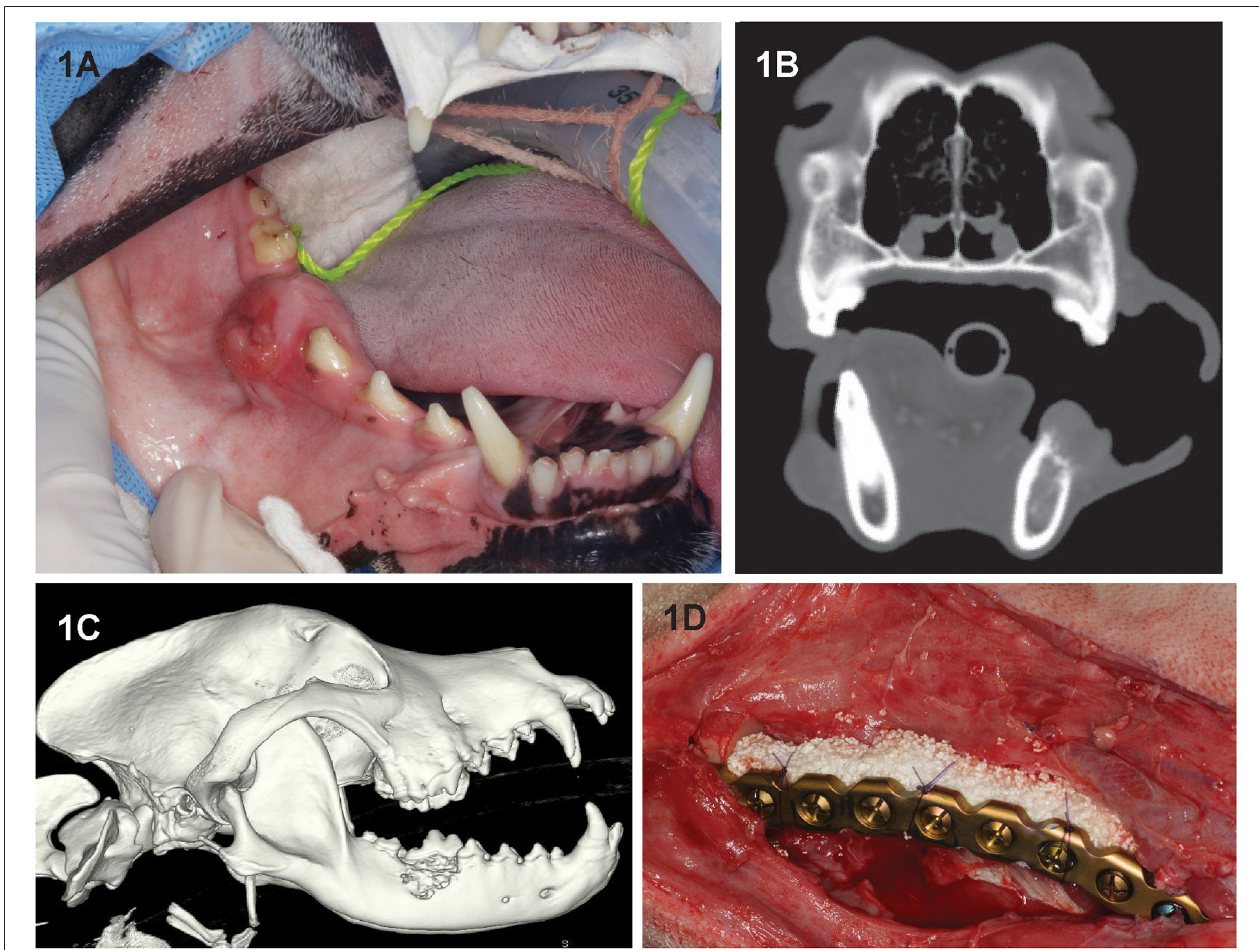
FIGURE 1 | Clinical image (A) of dog 2 prior to segmental mandibulectomy of histologically confirmed CAA at the level of right mandibular first molar tooth. (B) Sagittal-plane and (C) lateral view 3D volume rendering CT images of the same dog. Note that the neoplastic process extends almost to the ventral border of the mandibular canal and exhibits an osteodestructive pattern characteristic of CAA involving the dorsal half of the mandible. (D) Intraoperative image following mandibulectomy, replacement of the previously contoured reconstruction plate and insertion of rhBMP-2-soaked CRM implant into the defect (D) . The implant was secured to the plate using circumferentially placed poliglecaprone-25 (Monocryl, Ethicon, Somerville, NJ)